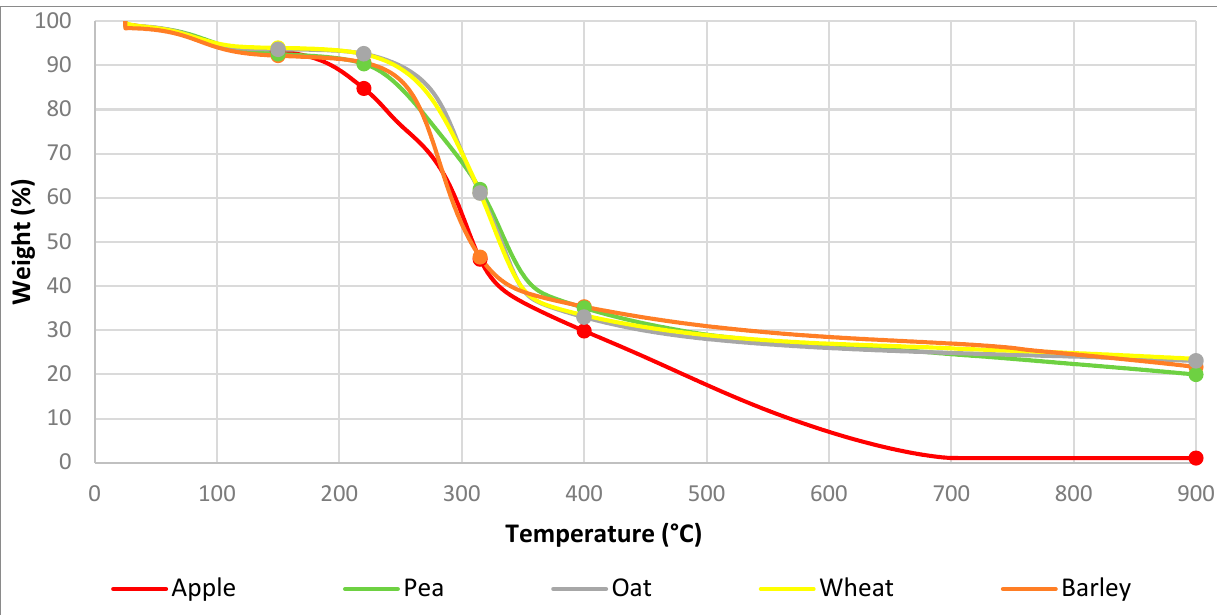
Figure 2. SEM image of Run 1 ( A ), Run 2 ( B ) and Run 3 ( C ) showing microspheres.